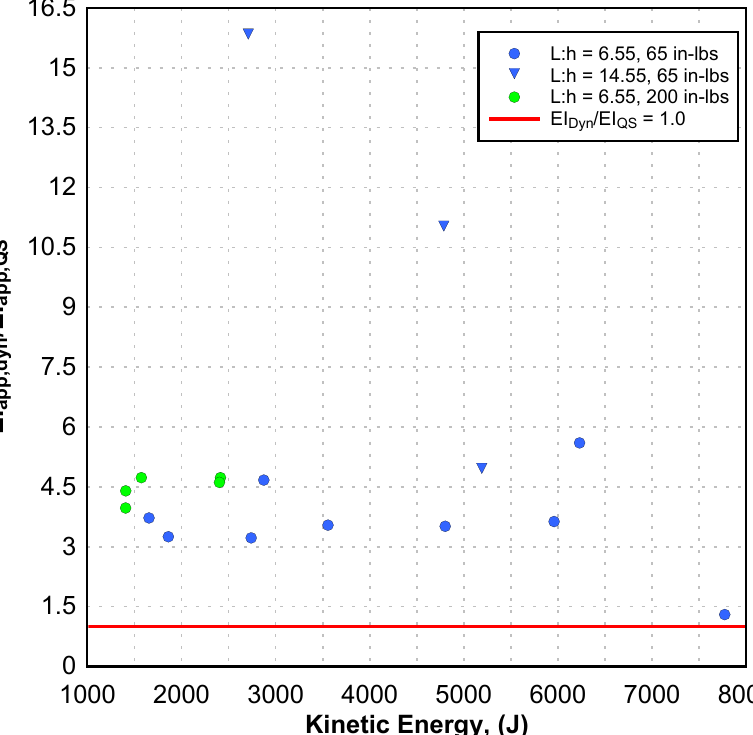
Figure 16. Dynamic apparent stiffness ratio for three-laminae specimens.